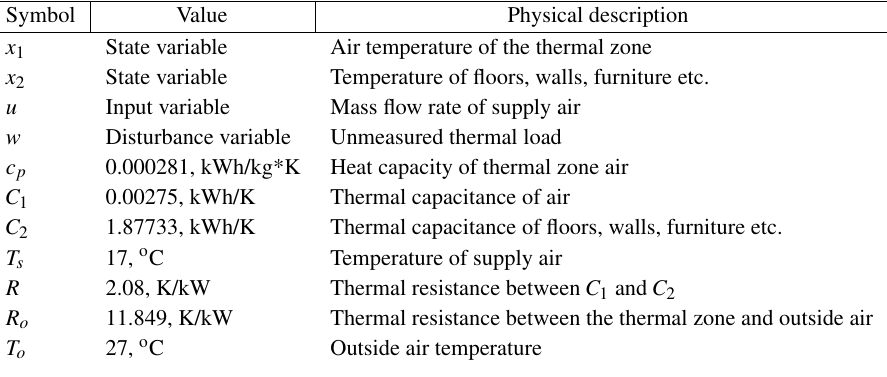
Table 2. Descriptions of different variables and parameters in model